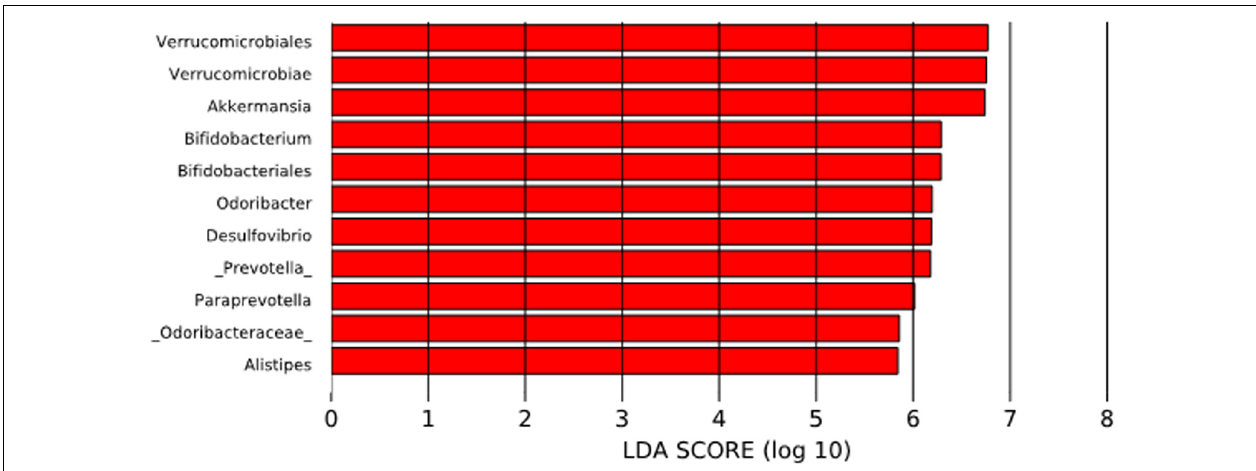
FIGURE 4 | Linear discriminant analysis (LDA) Effect Size (LEfSe) analysis of bacterial taxa present in the Chilean subjects and those from other countries. The significantly enriched populations are shown only for the Chilean